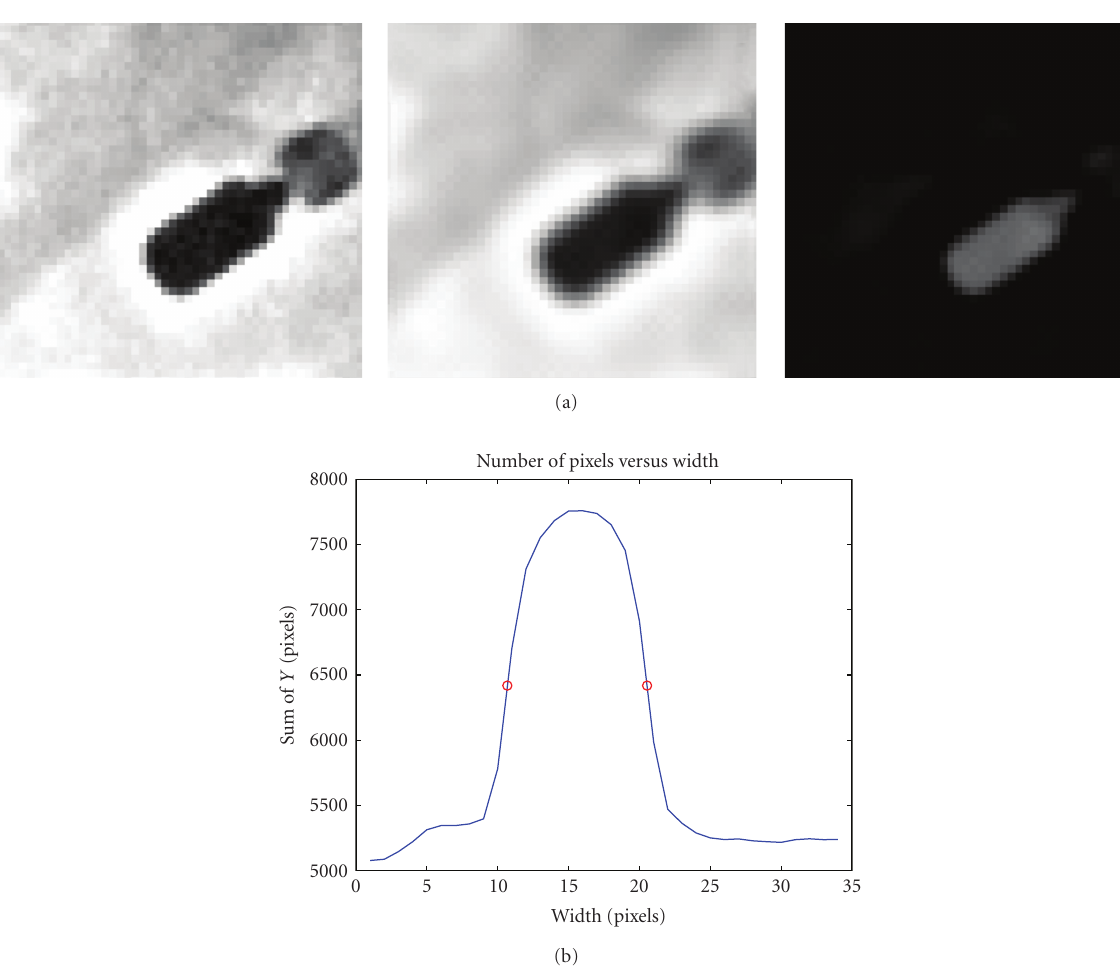
Figure 11: Projection approach applied to the tip electrode of an ablation catheter. (a) Homomorphic, anisotropic and morphological filter applied to tip electrode and (b) vertical projection of the electrode producing a bell shape curve used to estimate electrode width and area.